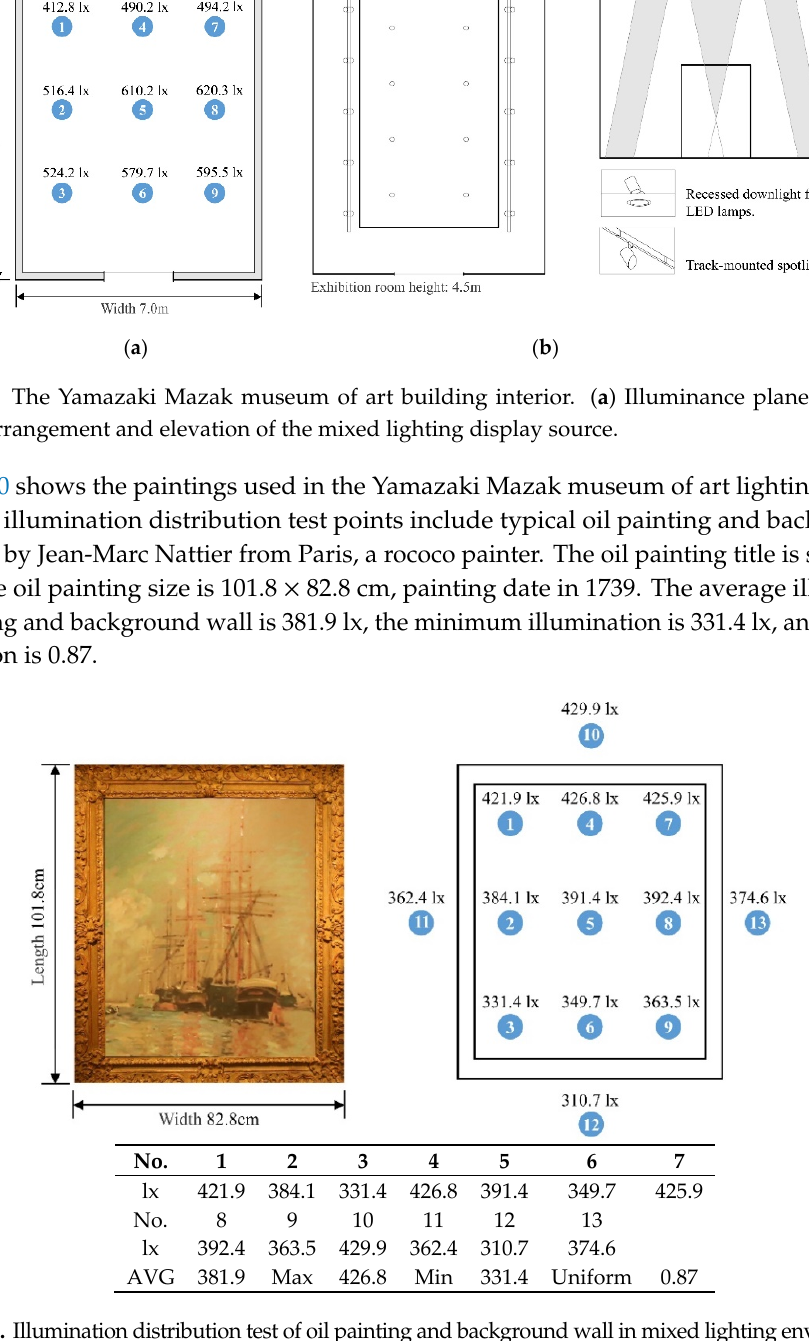
Figure 10. Illumination distribution test of oil painting and background wall in mixed lighting